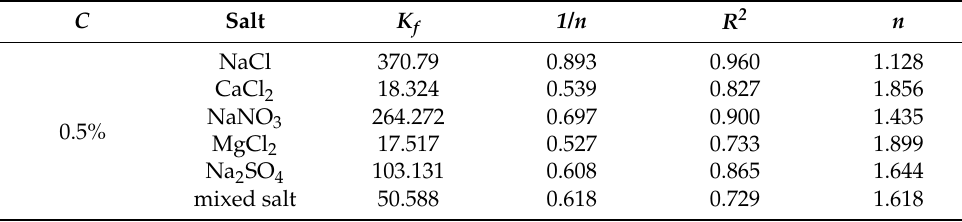
Table 2. Fitting results for the Freundlich